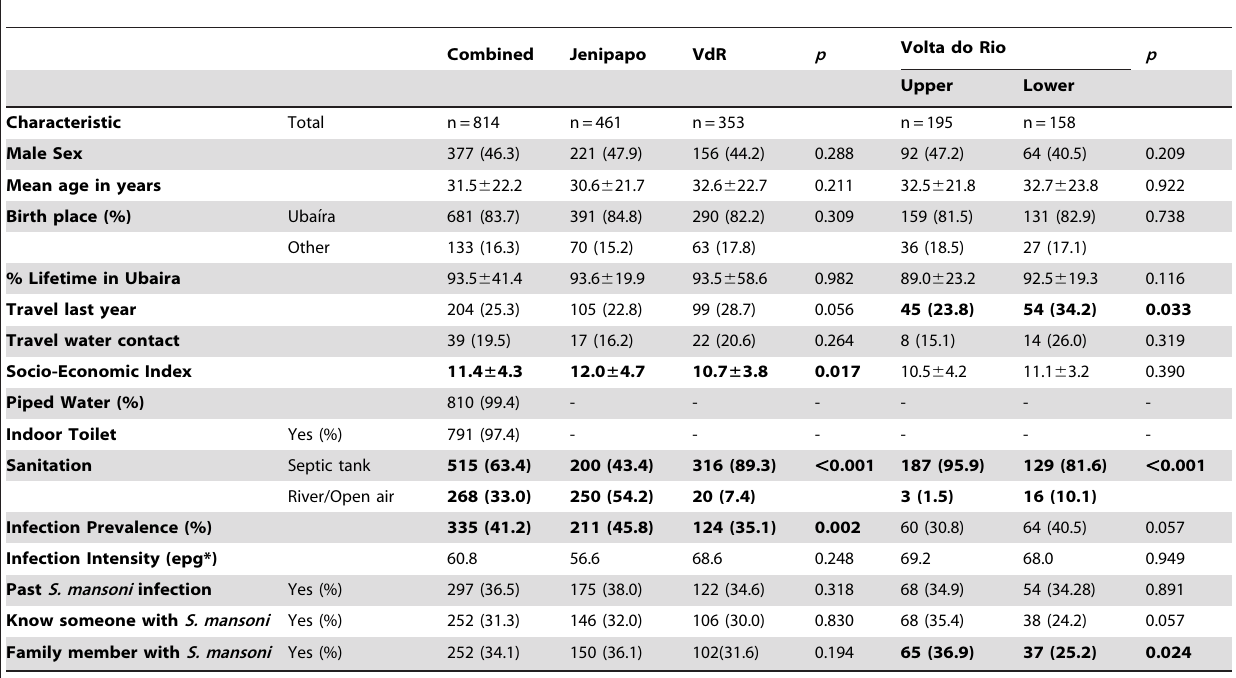
Table 1. Demographic, epidemiologic and infection characteristics of Jenipapo and Volta do Rio.